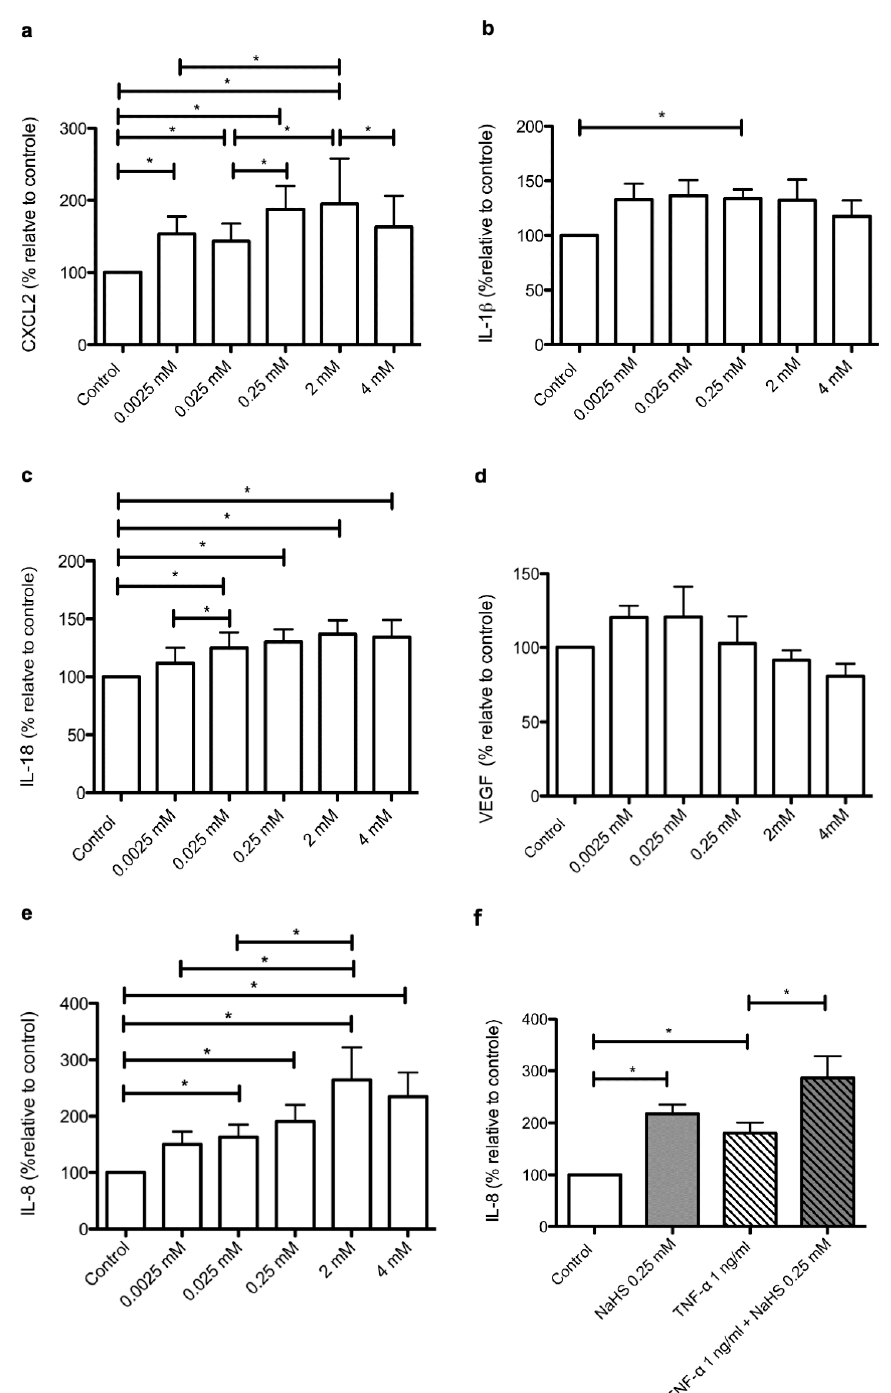
Figure 3. NaHS treatment modifies the cytokine/chemokine secretion profile of human epidermal cell sheets. Human epidermal cell sheets were cultured under control conditions or stimulated with NaHS at 0.0025, 0.025, 0.25, 2, or 4mM, alone or in combination with TNF- α (1 ng/mL Cell supernatants were then recovered 24 h after stimulation and the cytokines CXCL2 ( a ), IL-1 β ( b ), IL-18 ( c ), VEGF ( d ) and IL-8 ( e – f ) were measured by ELISA. Results are expressed as percentages relative to control measures observed in the absence of NaHS and / or TNF- α stimulation. Experiments were performed on epidermal cell sheets obtained from at least five distinct donors. The statistical significance of paired comparisons was assessed with the Wilcoxon test. *: p <